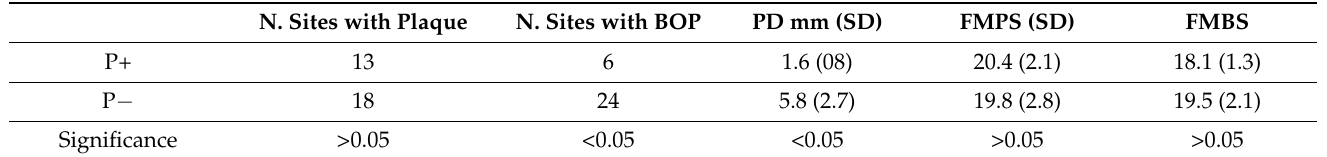
Table 2. Mean values recorded at the end of the follow-up period (T5).